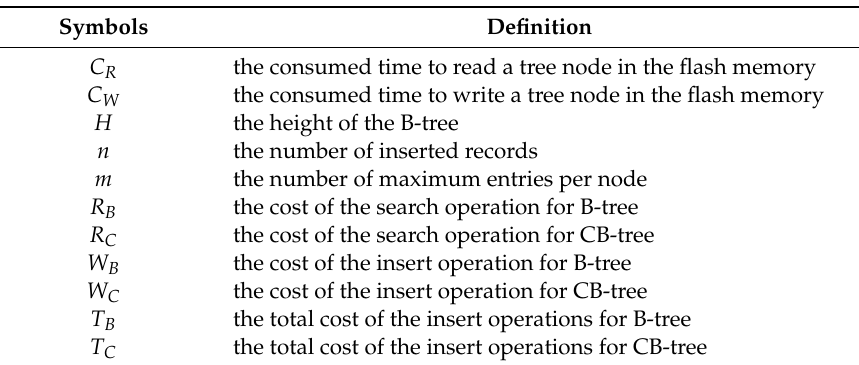
Table 2. Notation